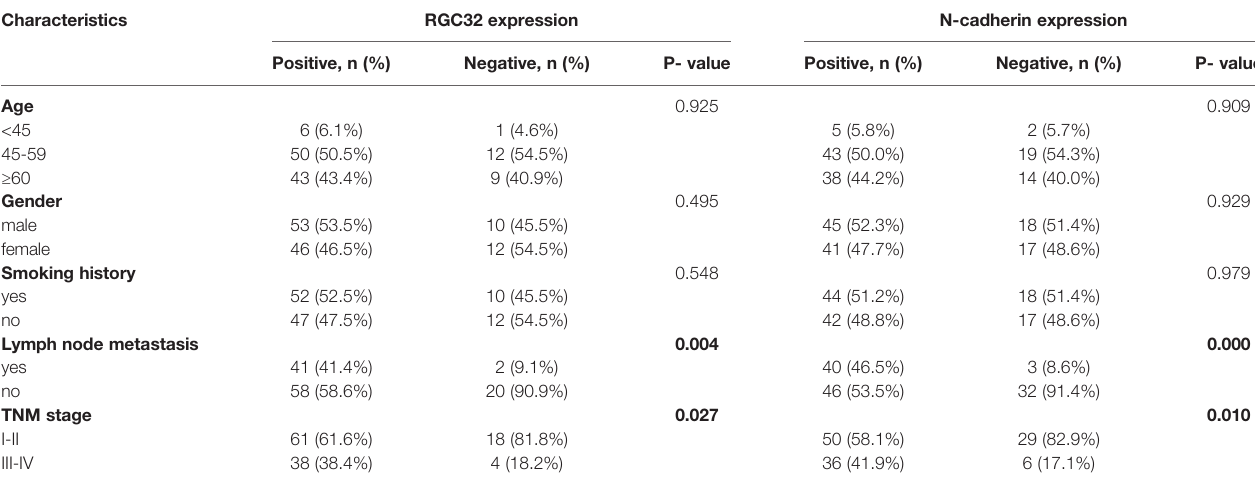
TABLE 1 | Baseline characteristics and expression of RGC32/N-cadherin of 121 lung adenocarcinoma patients.